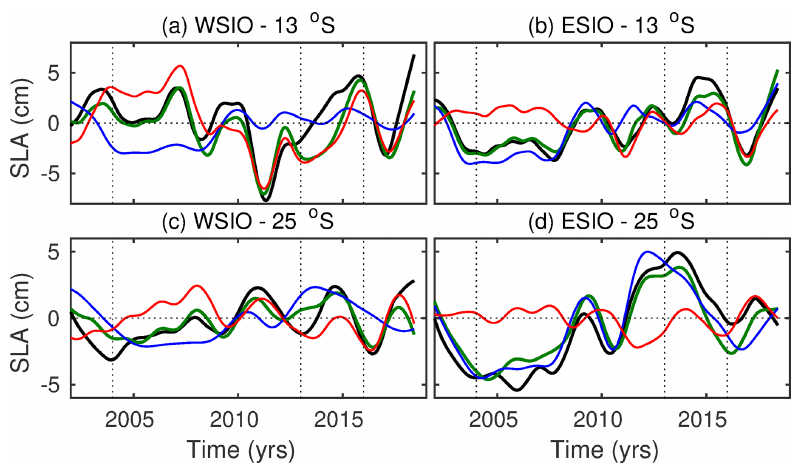
Figure 9. Time series of the simulated ECCO LLC270 SLA from the ITF-on simulation (black curves) and RG-modeled SLA using the eastern boundary forcing (blue curves), the local wind stress curl forcing (red curves), and both forcing terms (green curves), averaged between (a, c) 55–90 ◦ E and (b, d) 90–110 ◦ E at 13 ◦ S (a, b) and 25 ◦ S (c, d) . Vertical dashed lines indicate the years 2004, 2013, and